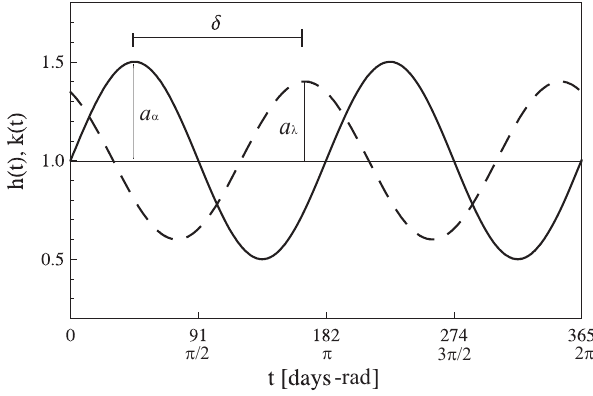
Fig. 1. Example of the h(t) (solid) and k(t) (dashed) curves, see Eq. (2). The temporal shift δ between the seasonal peaks is indi- cated, as well as their amplitudes, a α and a λ . In this case n